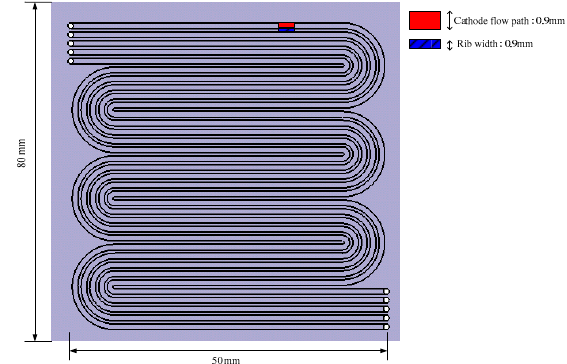
Figure 5. Schematic of the unit-cell channel shape.